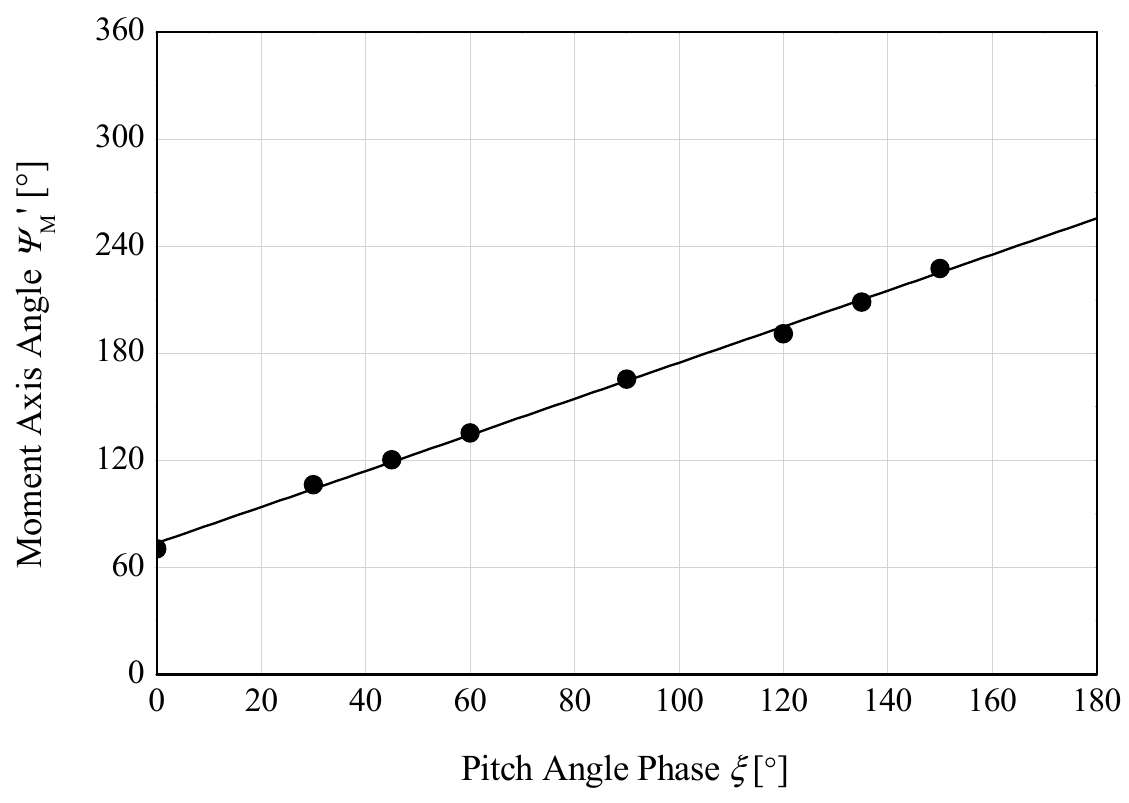
Figure 11. Relationship between the moment-axis angle and the angle phase.